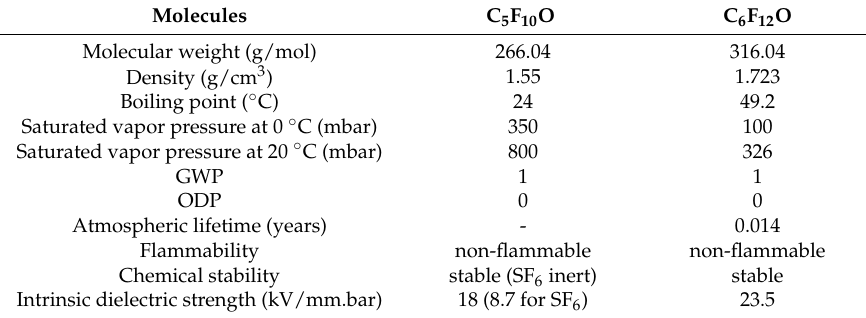
Table 9. Physicochemical and environmental properties of two fluoroketones [36,37].